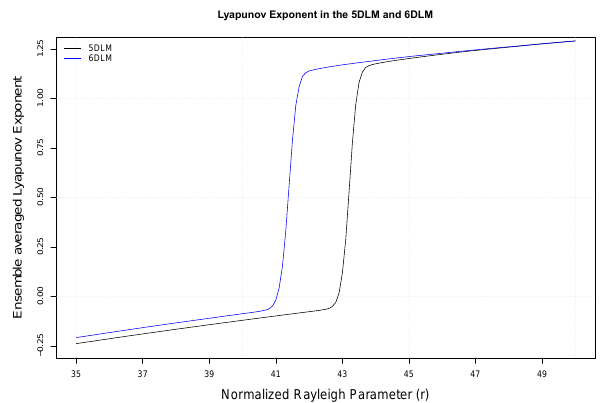
Figure 4. The largest ensemble-averaged Lyapunov exponents (eLEs) as a function of the forcing parameter r in different LMs. The eLEs with (cid:49)r = 0 . 1 for the 5DLM (black) and 6DLM (blue). The appearance of chaotic solutions is indicated by positive eLEs.